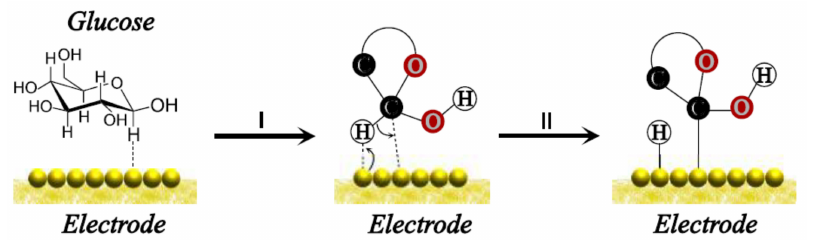
Figure 4. Illustration of the glucose–electrode interaction in the Pletcher model.